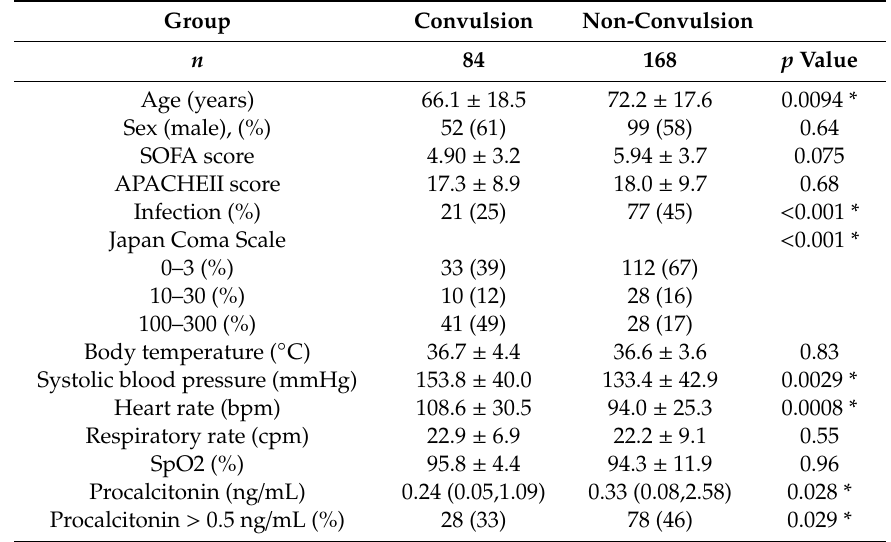
Table 1. Basic patient characteristics of the two groups. Infection, Japan Coma Scale, systolic blood pressure, heart rate, and procalcitonin were higher in the convulsion group than in the control group. Group Convulsion